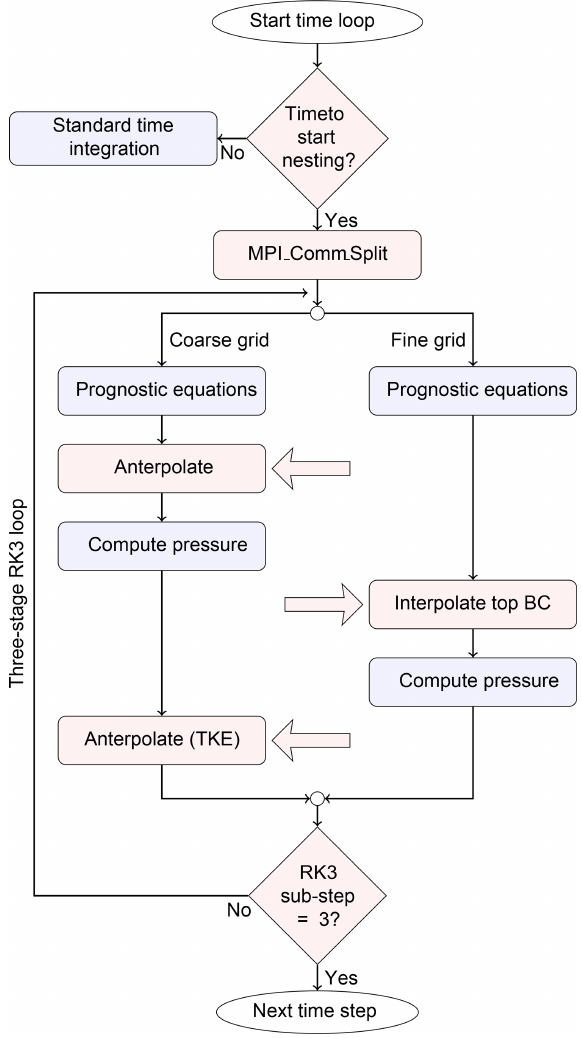
Figure 2. A flowchart of the two-way interaction algorithm. The new routines needed for the vertical nesting are highlighted in red and the standard routines are highlighted in blue. An arrow pointing to the left indicates transfer of data from FG to CG, and vice